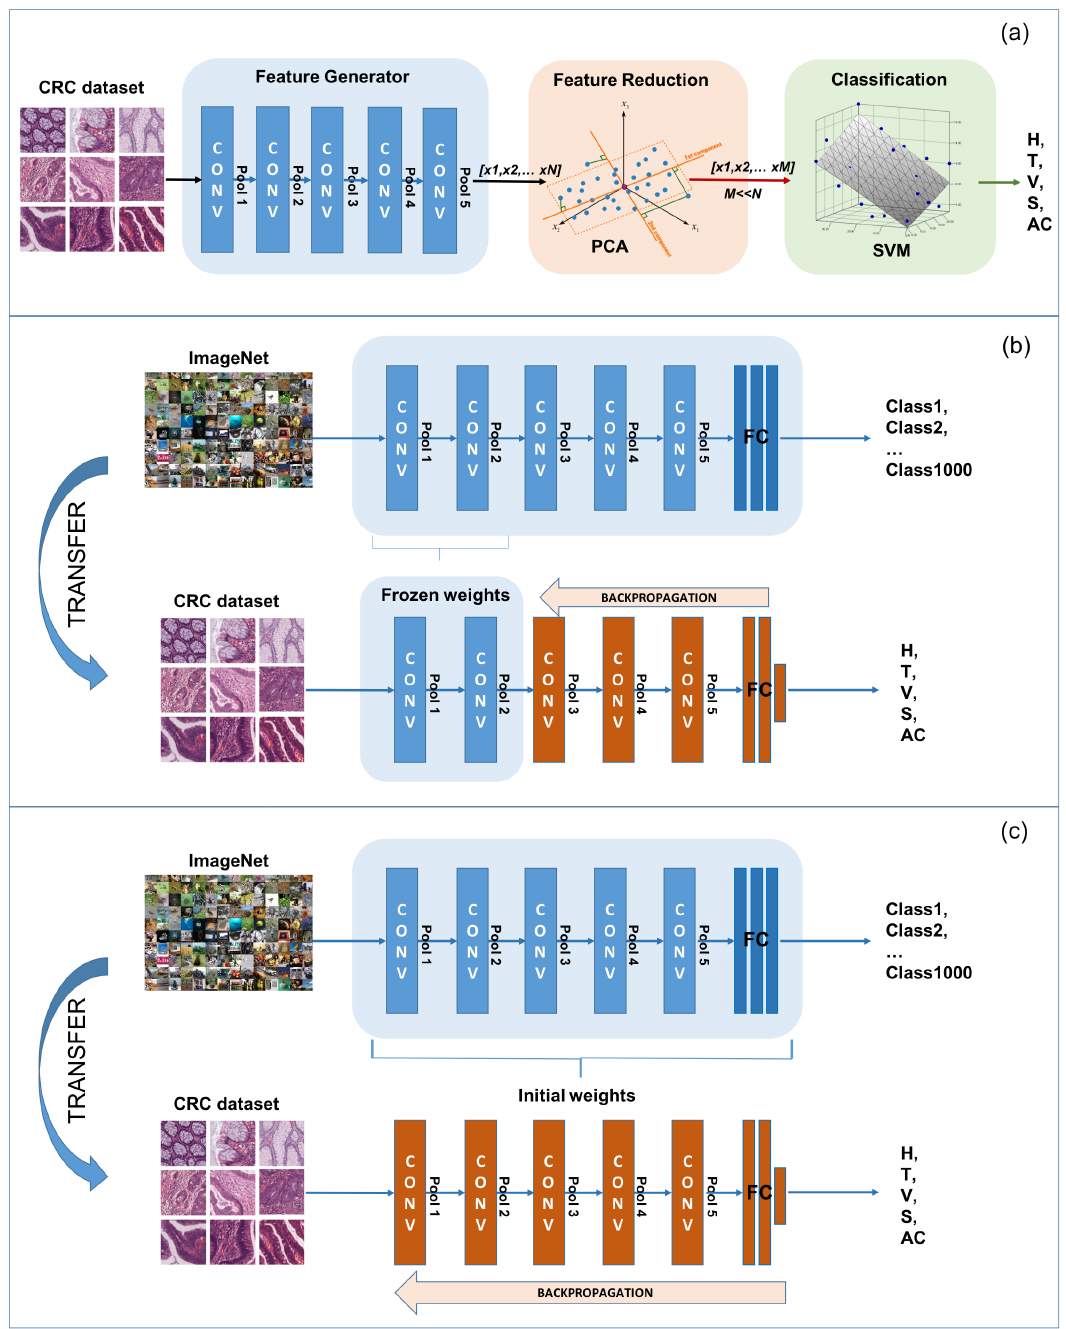
Figure 5. Schematic representation of the three transfer learning techniques designed and compared in this work: ( a ) Pre-trained CNN as a fixed feature generator. ( b ) Partial fine-tuning of pre-trained CNN. ( c ) Complete fine tuning of pre-trained CNN. CRC, Colorectal Cancer; H, Hyper-plastic polyp; T, Tubular adenoma; V, Villous adenoma, S, Serrated adenoma; AC,